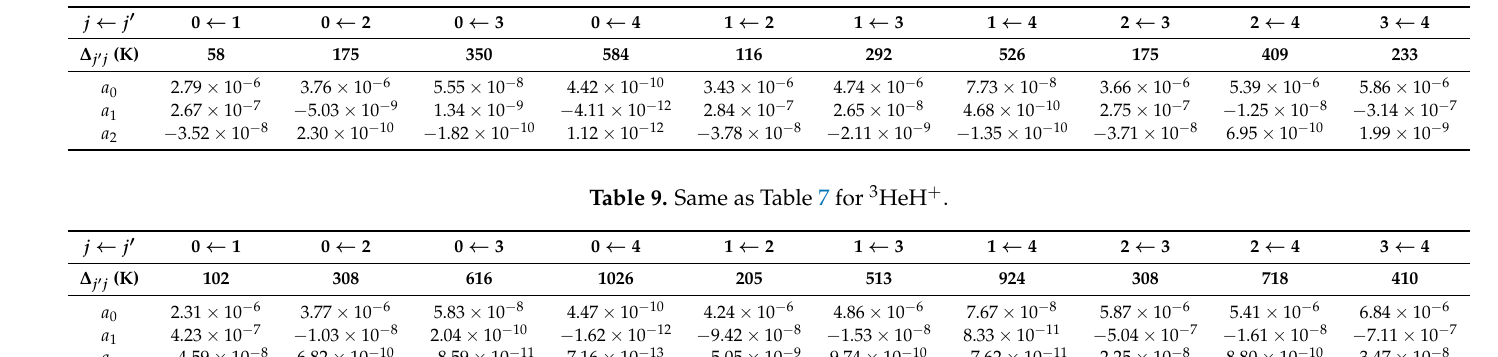
Table 8. Same as Table 7 for 4 HeD + .